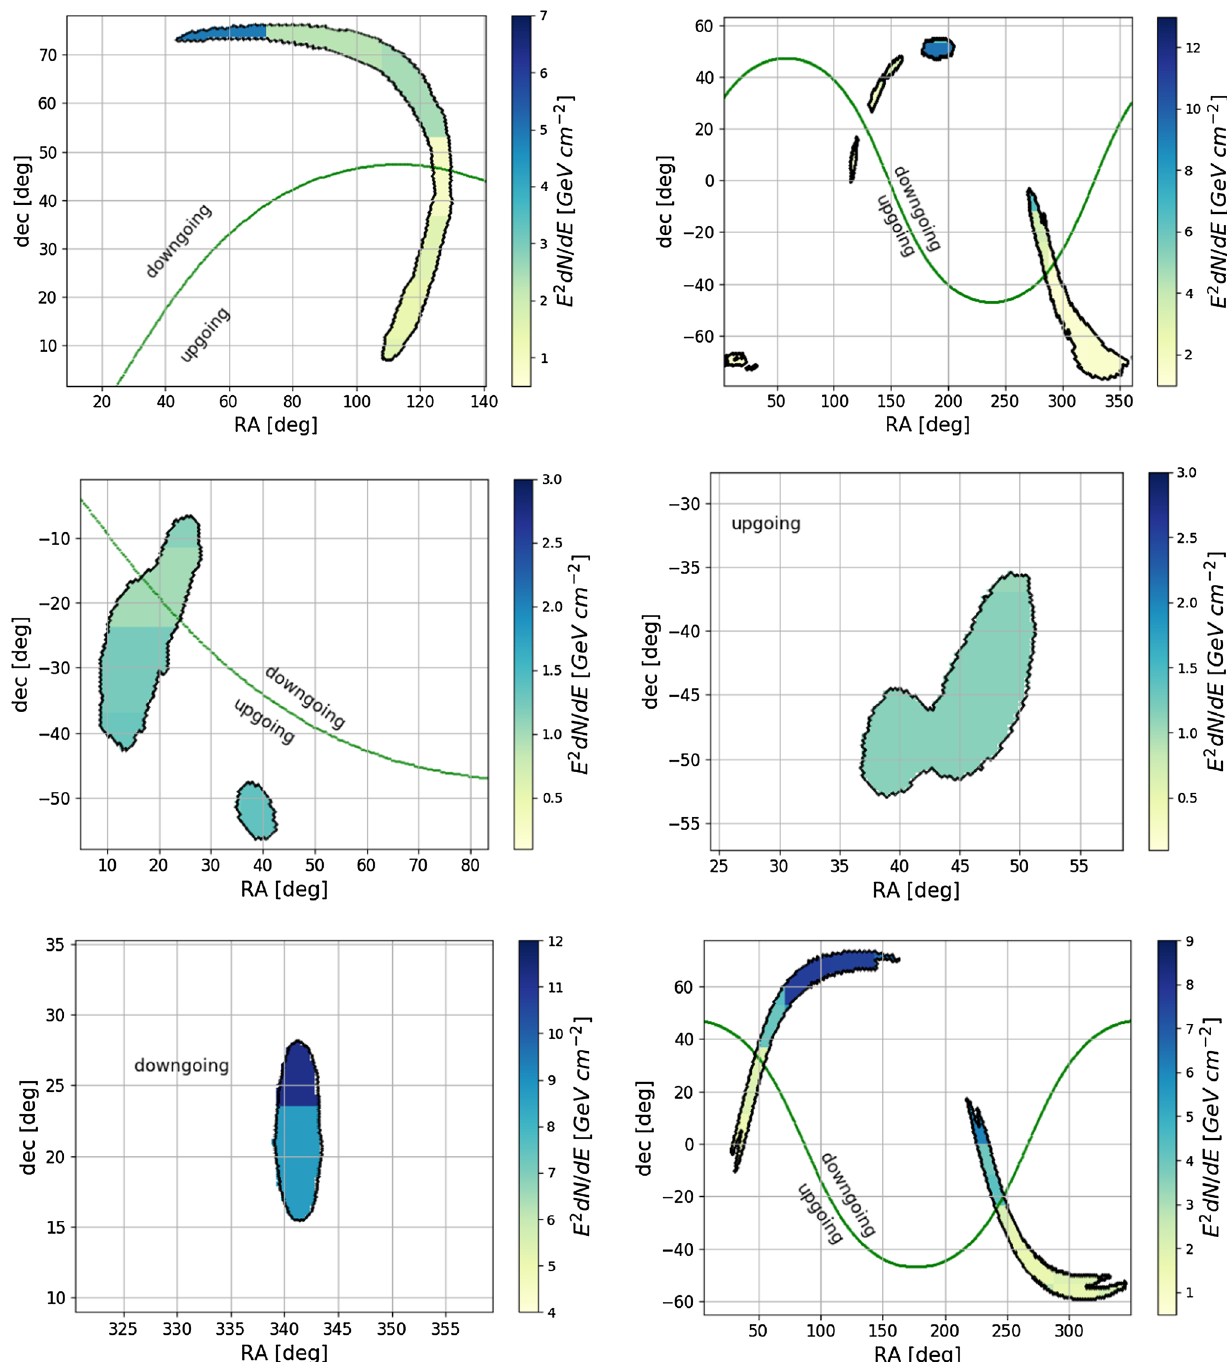
Fig. 1 Upper limits on the neutrino spectral fluence (colored scale) as a function of the position in the sky in equatorial coordinates, com- puted assuming an E − 2 neutrino spectrum. The events are shown in chronological order: GW170608 (upper left), GW170729 (upper right), GW170809 (middle left), GW170814 (middle right), GW170818 (bot-